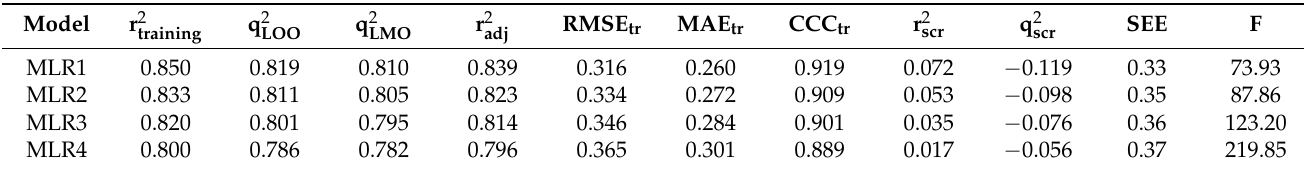
Table 2. Fitting and cross-validation statistical results of the MLR models *.